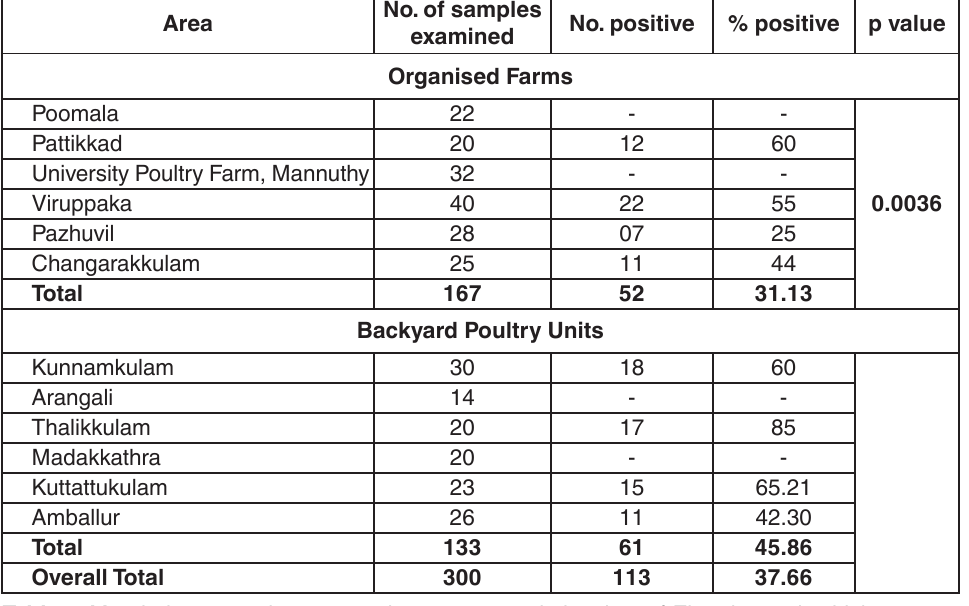
Table 2. Morphology, morphometry and average sporulation time of Eimeria spp. in chicken species